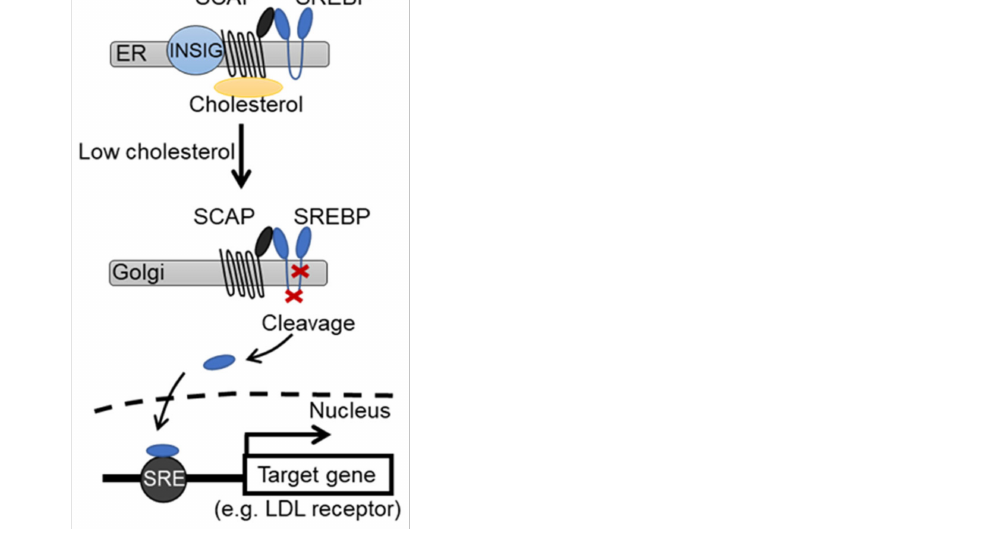
Figure 1. Genetic effects of cholesterol on sterol synthesis and low-density lipoprotein (LDL) receptor